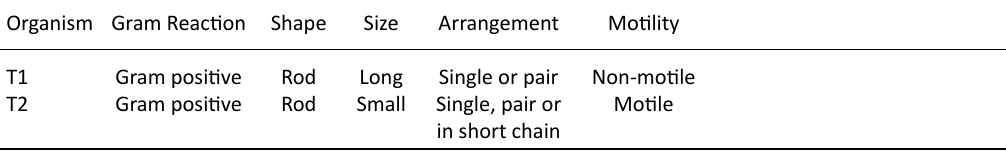
Table 1. The size, shape, margin, texture, elevation, opacity, pigment of two organisms are noted Organism Size Shape Margin Texture Elevation Opacity Pigment T1 Big Circular Entire Smooth Flat Opaque Nil T2 Small Puncta form Fimbriate Smooth Table 2. The shape, size, arrangement and motility of the two organisms are noted Organism Gram Reaction Shape Size Arrangement Motility T1 Gram positive Rod Long Single or pair Non-motile T2 Gram positive Rod Small Single, pair or Motile in short